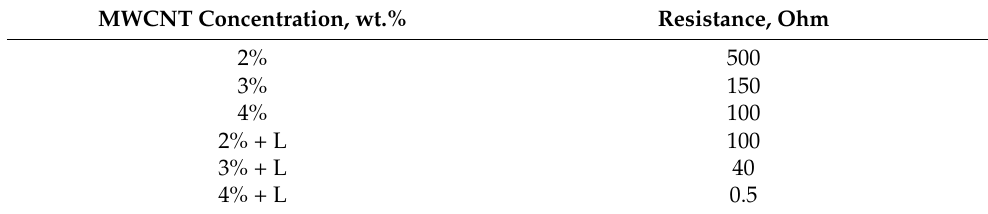
Table 3. Dependence of electrical resistance on the concentration of MWCNT. MWCNT Concentration, wt.%